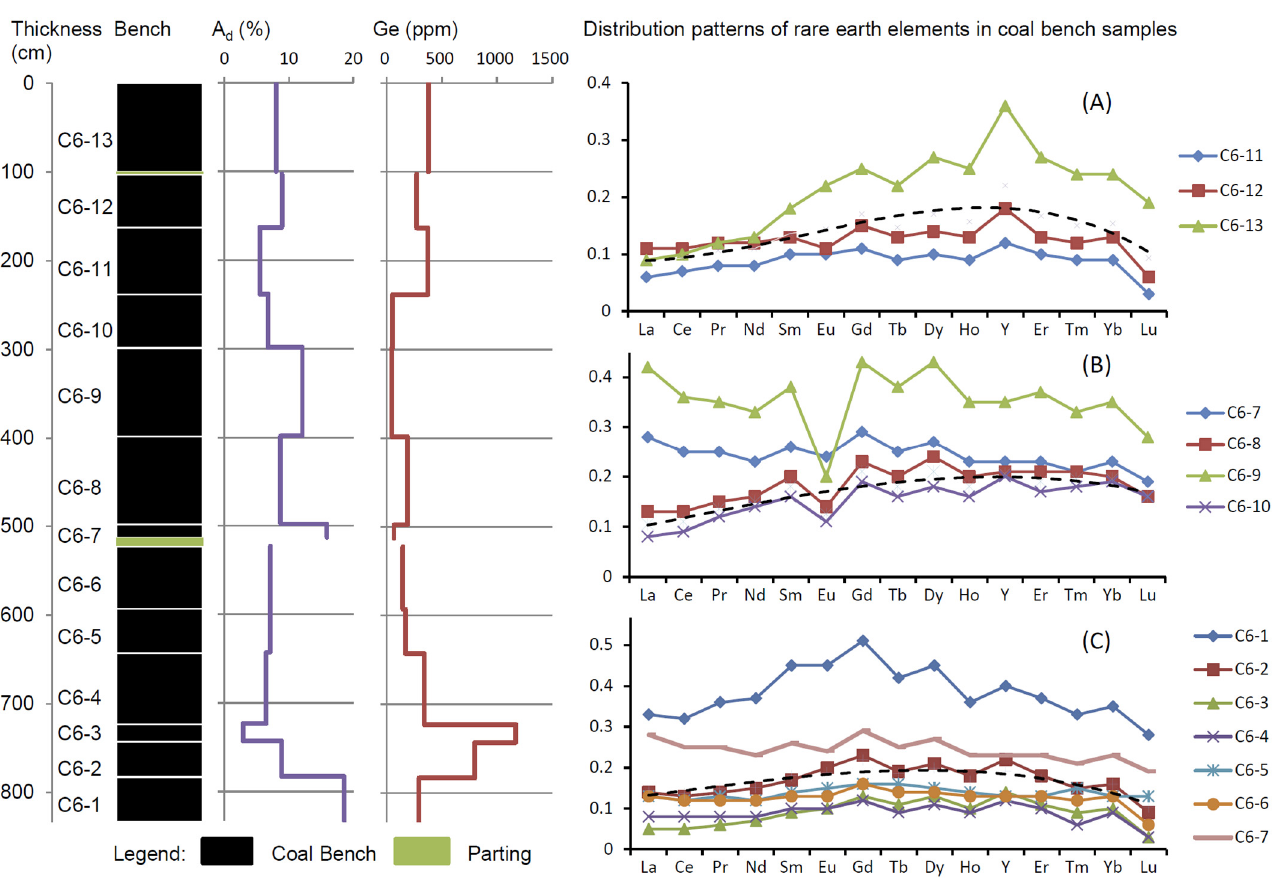
Figure 18. Ash yield, Ge concentration (whole-coal basis), and REY distribution pattern in the sec- tion of the No. 6 Coal. REE plots (after Dai et al. [131]) normalized to Upper Continental Crust (UCC) [71]. ( A ), REY distribution patterns of the upper section of the coal seam including benches C6-11, C6-12, and C6-13; ( B ), REY distribution patterns of the middle section of the coal seam including benches C6-7 to C6-10; ( C ), REY distribution patterns of the lower section of the coal seam including benches C6-1 to C6-7.